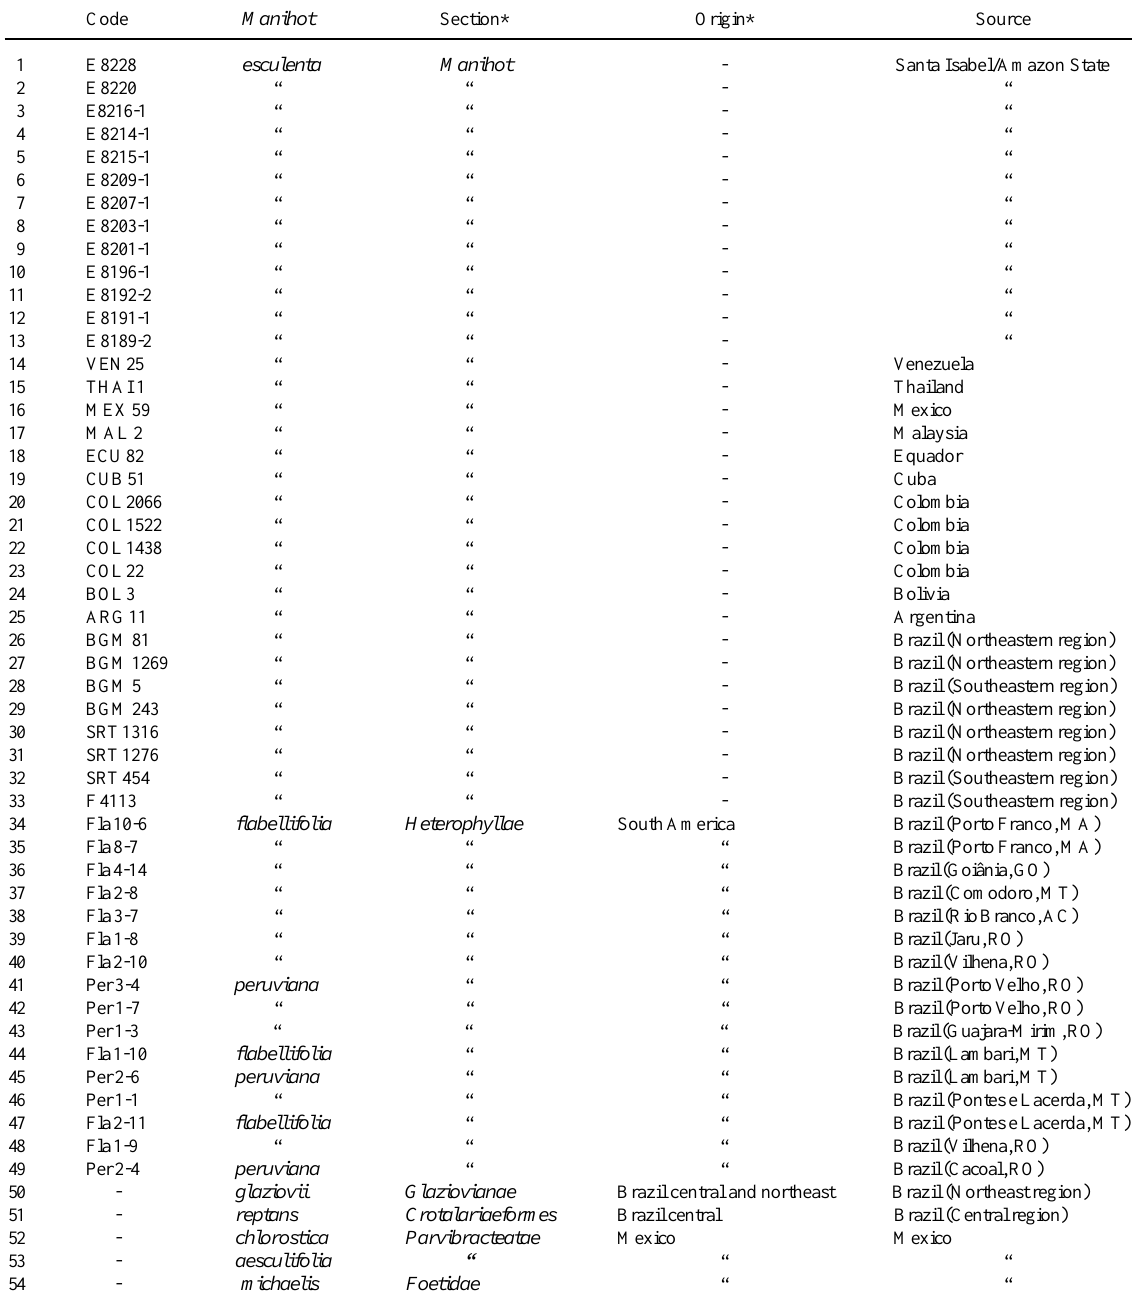
Table I - Plant samples used to investigate the genetic relatedness among Manihot